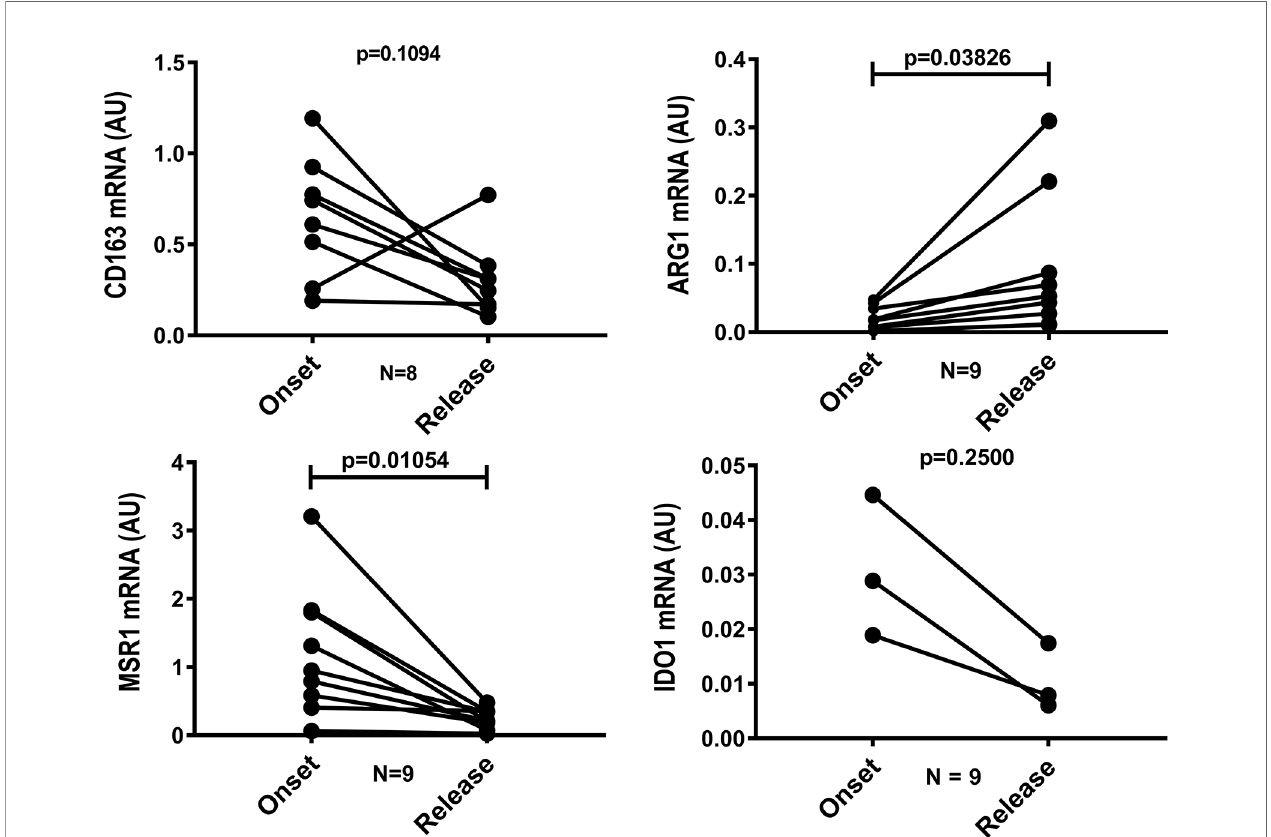
FIGURE 2 | Gene expression of MSR1 is reduced and ARG1 increases after 12 doses of MDT. Skin lesions fragments were collected at LL diagnosis (onset) and at release of 12-dose MDT. RNA was extracted, cDNA was synthesized and the expression of CD163 , ARG1 , MSR1 and IDO1 genes was evaluated by real-time PCR. Graph shows the gene expression of each patient at disease onset and 12-dose MDT